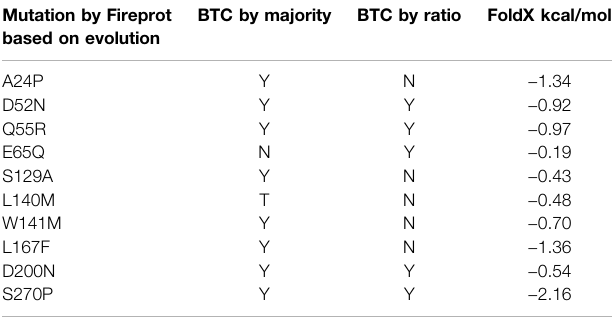
TABLE 1 | Single-point mutations predicted by Fireprot based on evolution. Mutation by Fireprot based on evolution